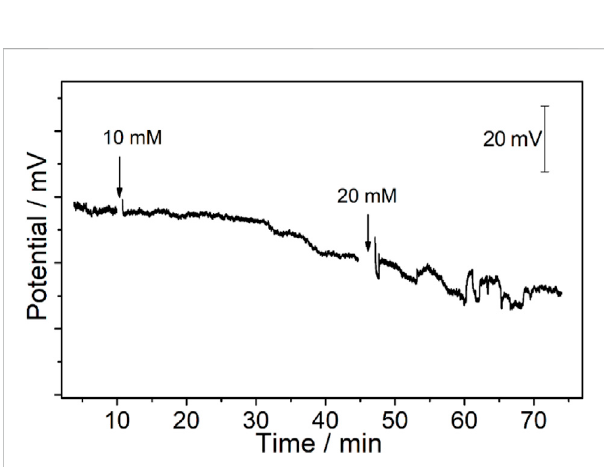
FIGURE 7 Potentiometric time trace of the CF μ Es/PEDOT (PSS)/Ca 2+ -ISE toward Ca 2+ after theelectrodeisplacedon thecytomembrane ofthe renal carcinoma cell. The arrow points to the time point of adding different concentrations of K + to obtain fi nal concentrations of 10 mM and 20